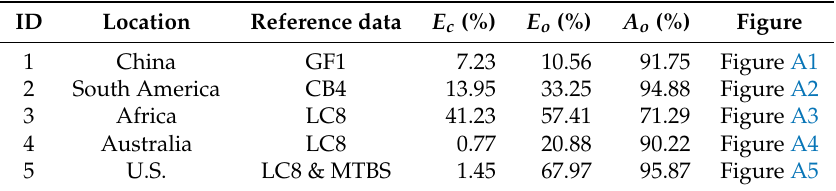
Table A1. Information of site validation examples. GF,